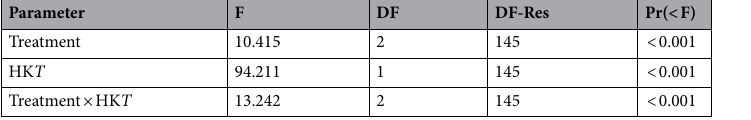
Table 3. The effect of acclimation treatment and ramping rate on HKDT. DF = degrees of freedom, DF-Res = degrees of freedom residuals, F = F ratio, Pr(< F) = p value associated with the F-statistic.